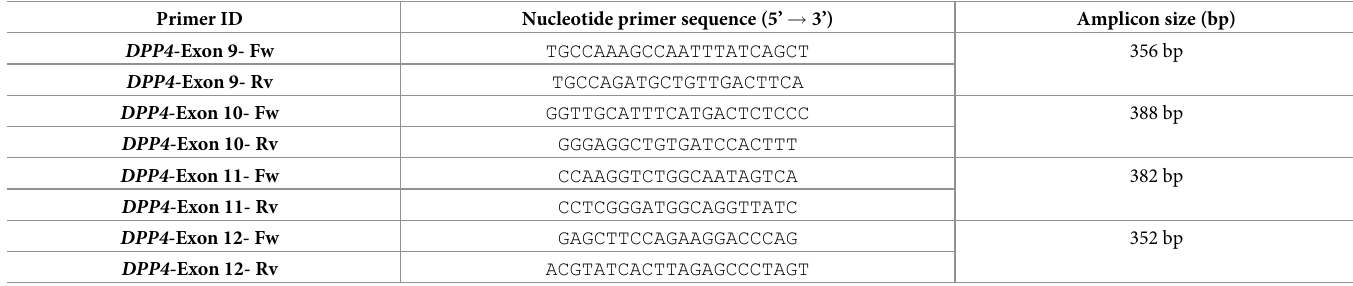
Table 1. Summary table of designed primers for amplification and sequencing of hDPP4 gene exons 9, 10, 11 and